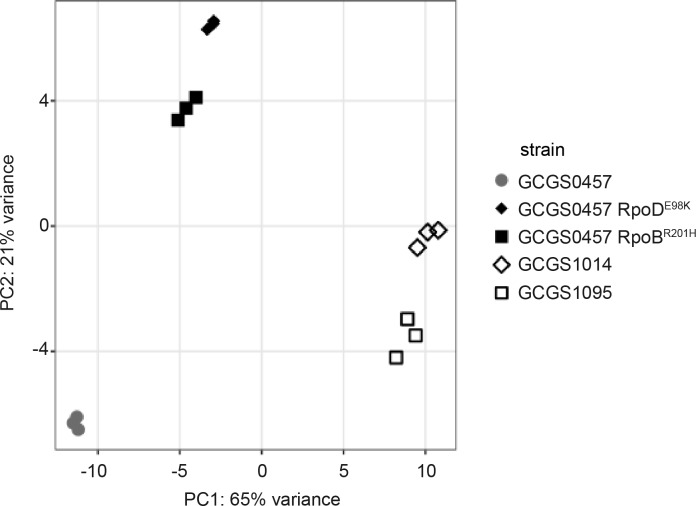
Principle components analysis of RNA-seq data.The first two principle components are shown for transcriptomic data collected from the CROS isolate GCGS0457, the CRORS isolates GCGS1095 and GCGS1014, and the CRORS transformants GCGS0457 RpoDE98K and GCGS0457 RpoBR201H (three biological replicates/strain). Replicates from both CRORS transformants cluster tightly, despite having different RNAP mutations.